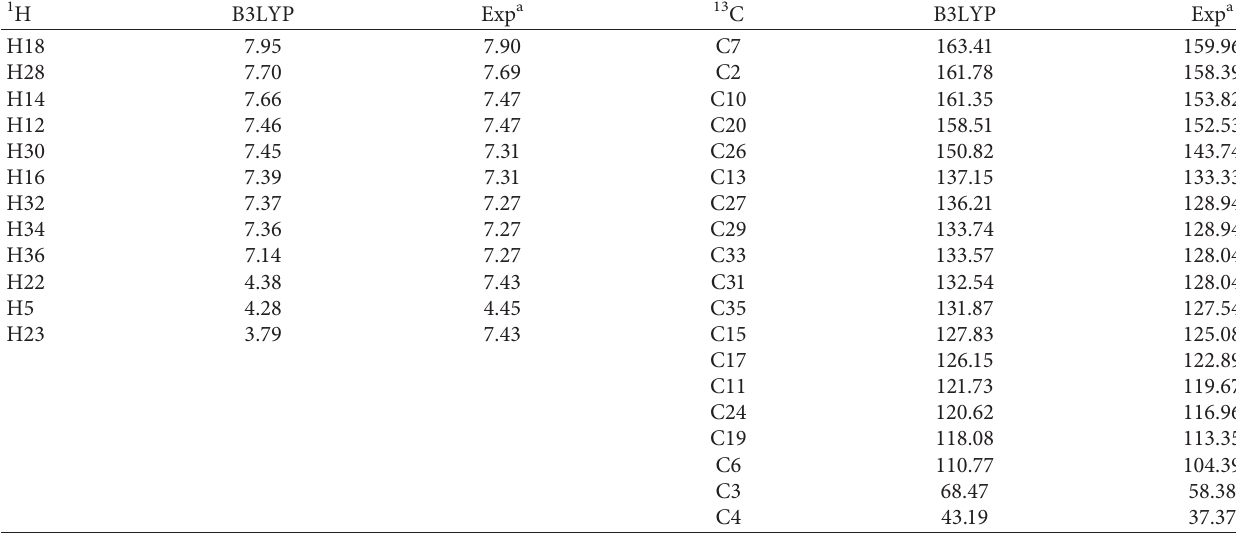
Table 3: Calculated 1 H-NMR and 13 C-NMR chemical shifts ( δ (ppm)) based on the TMS B3LYP/6 311+G(2d,p) GIAO reference compared with the experimental